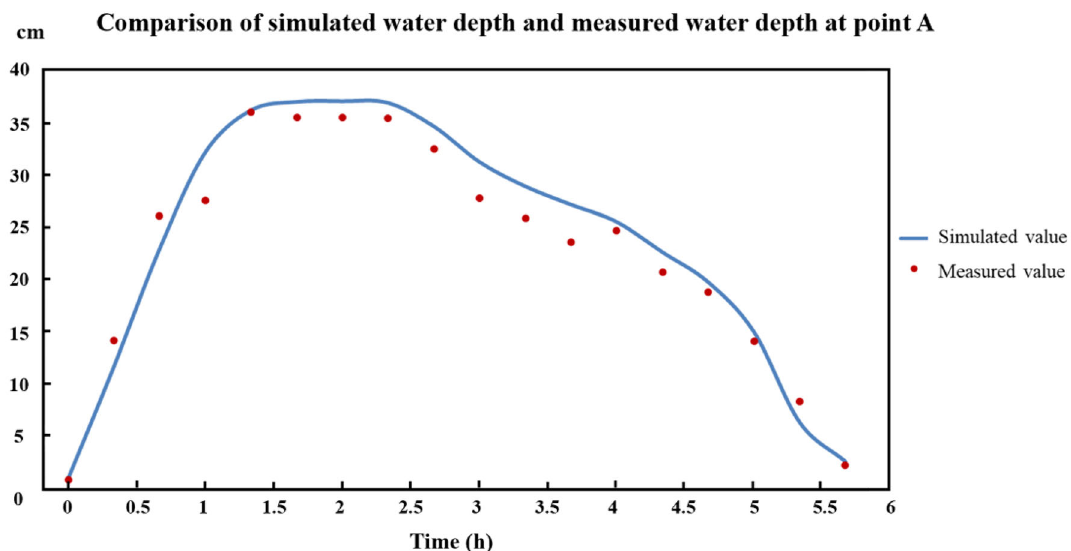
Fig. 9 Comparison between simulated and measured water processes (from 22:50 on 1 August to 4:30 on 2 August 2019) at station A in the study area on Jiefang South Road in Tianjin Municipality, China Fig. 10 Comparison between simulated and measured water processes (from 22:20 on 1 August to 1:00 on 2 August 2019) at station E in the